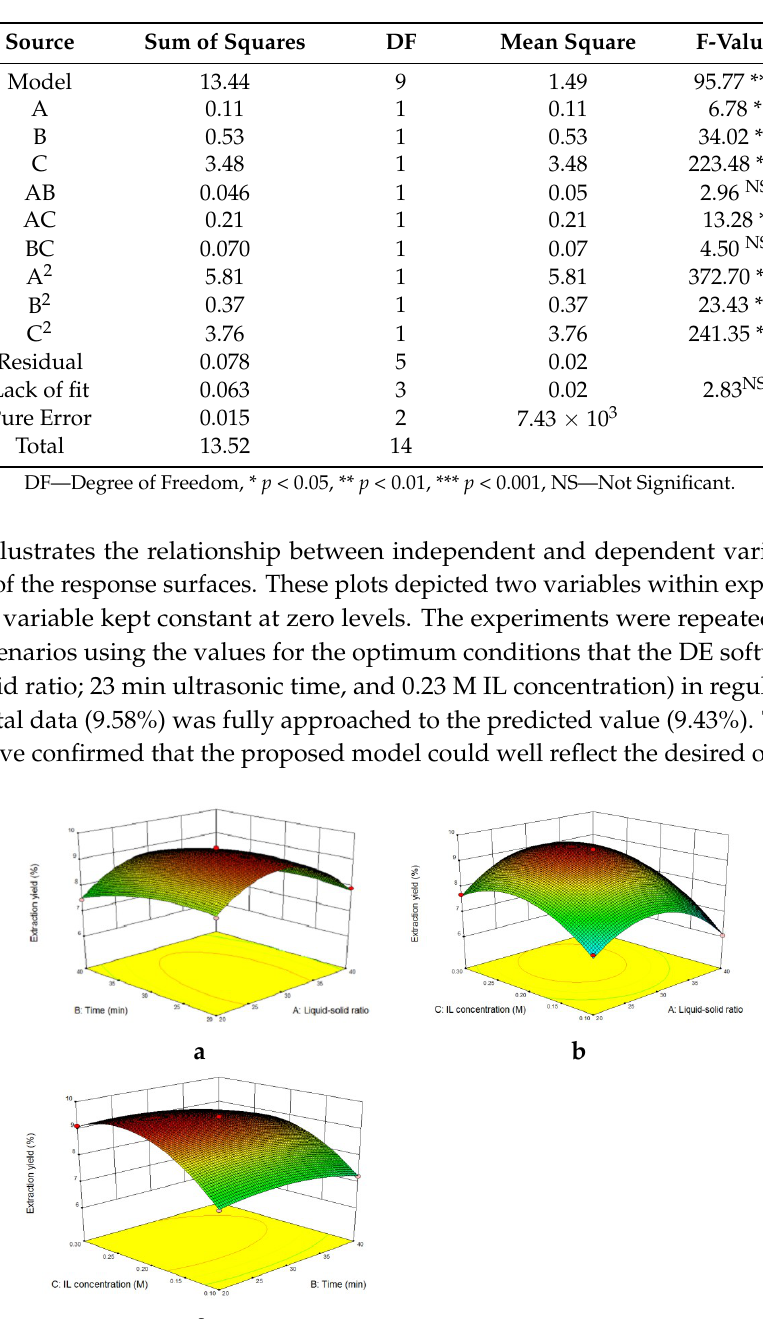
Table 2. Analysis of variance for the response surface of extraction yield (%) of ginsenosides using IL-UAE.